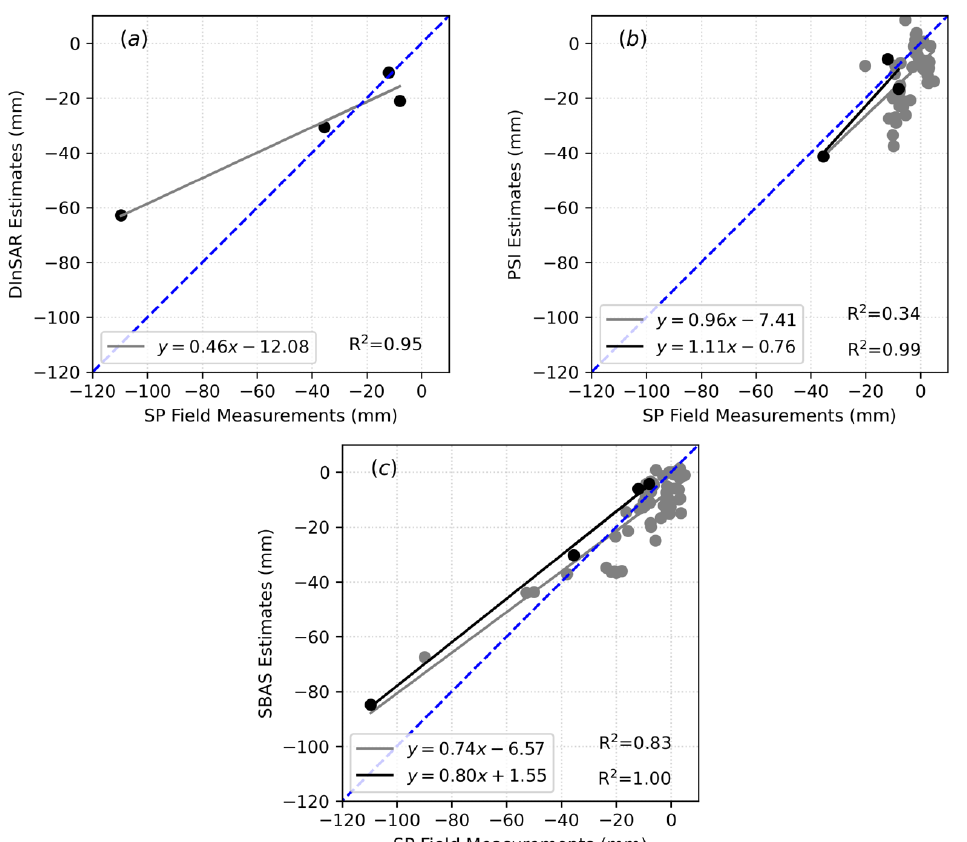
Figure 11. Comparison between SP measurements and ( a ) DInSAR estimates, ( b ) PSI estimates, and ( c ) SBAS estimates. The regression models with black lines only considered the final ground movement values, whilst the grey lines considered all the recorded and estimated values within the study period.